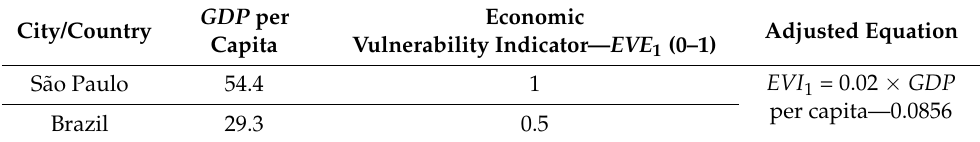
Table 17. Economic vulnerability indicator ( EVI 1 )